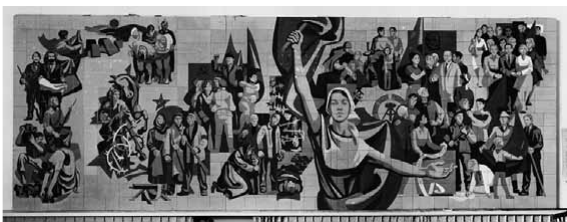
fig. 2. Der Weg der Roten Fahne . Gerhard Bondzin and collective, 1969. SluB Dresden / Deutsche fotothek / Helmut